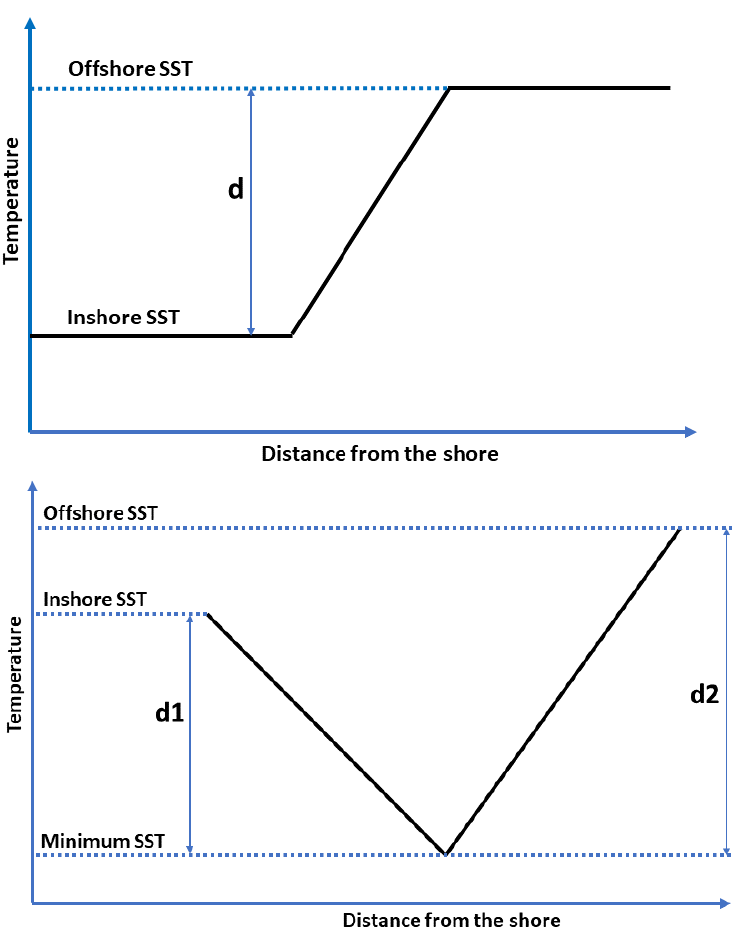
Figure 10. Ramp model ( top ) vs. valley model ( bottom ). d, offshore SST − inshore SST; d1, inshore SST − minimum SST; d2, offshore SST − minimum SST.